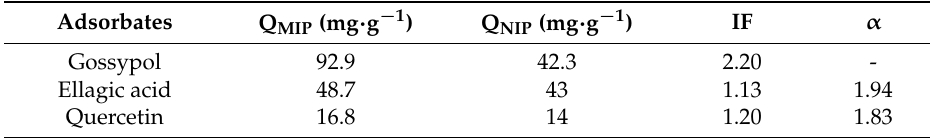
Figure 7. The selective adsorption capacity of the MIP, NIP and its silica support spherical (60 µ m) toward gossypol, ellagic acid and quercetin solution, respectively (10 mg of absorbents in 5.0 mL 200 mg · L − 1 gossypol solution for 1 h). Table 5. The adsorption capacity, imprinting factors (IF) and selectivity coefficients ( α ) of gossypol, ellagic acid and quercetin of MIP and NIP using spherical silica (60 µ m) as the